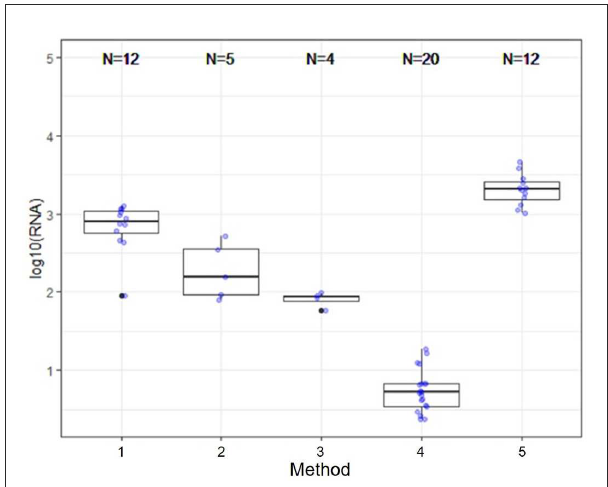
FIGURE1 Extraction and viral concentration method significantly effects RNA concentration. While all five methods are capable of detecting SARS-CoV-2 by qPCR, as demonstrated by the data reported by the OCWMN, only methods 2 and 3 produced similar RNA concentrations. Therefore, metatranscriptome results could be highly variable between sites due to differences in extraction